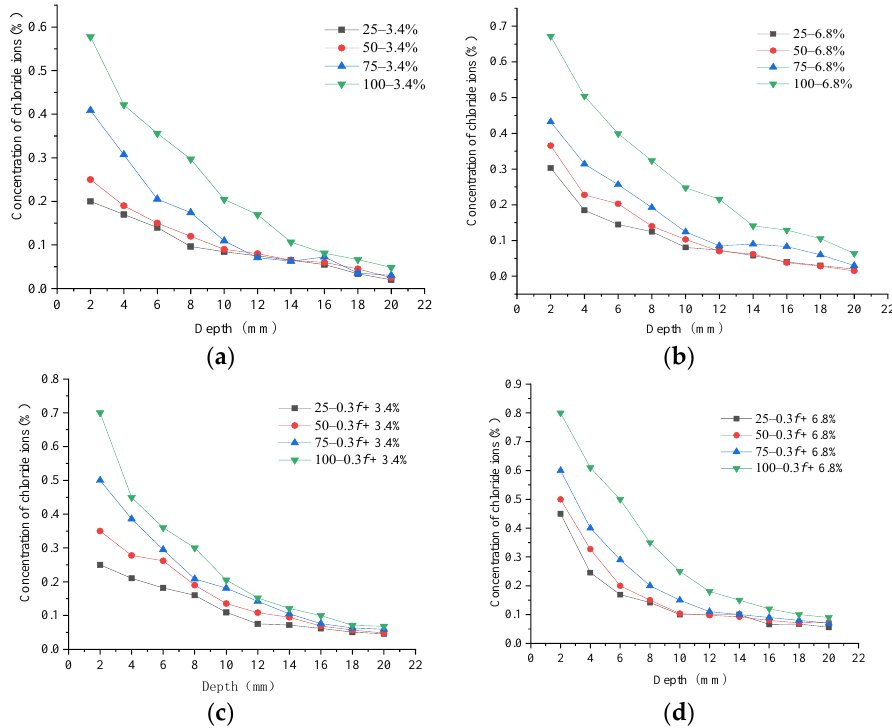
Figure 5. Concentrations of chloride ions at various depths in the concrete samples after various numbers of freeze – thaw cycles. ( a ) After no initial load in a 3.4% composite salt solution. ( b ) After no initial load in a 6.8% composite salt solution. ( c ) After an initial 0.3 f load in a 3.4% composite salt solution. ( d ) After an initial 0.3 f load in a 6.8% composite salt solution.